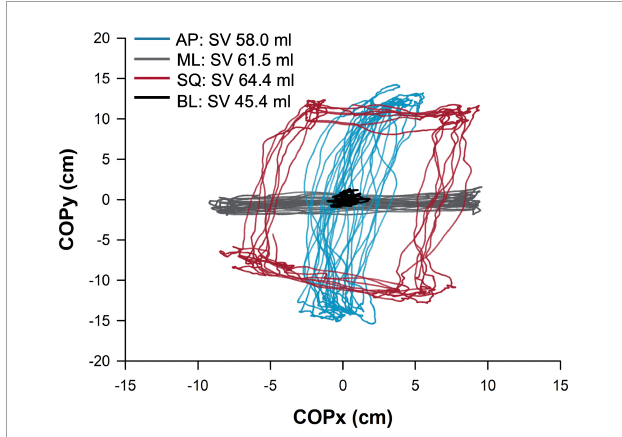
FIGURE1 Sample trace showing postural sway in the four conditions in a representative participant. The path (cm) of the centre of pressure is shown, normalized to the origin, during baseline (BL; quiet standing) and exaggerated mediolateral (ML), anterior-posterior (AP), and square (SQ) sway conditions. The participant’s stroke volume (SV) during each condition is provided in the legend. COPx,y, movement of center of pressure in x or y